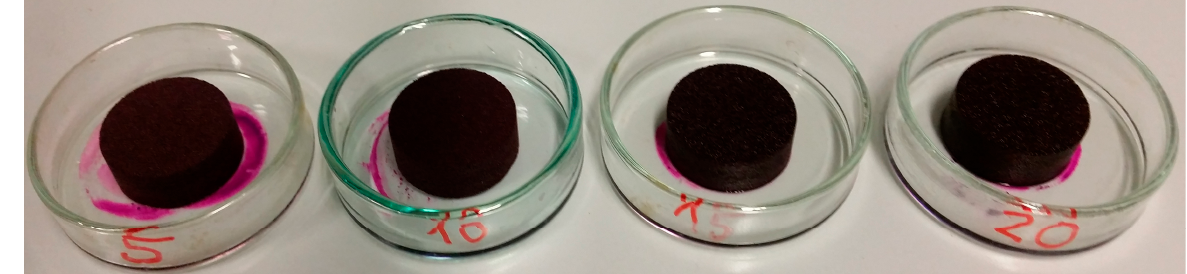
Figure 1. Impregnated catalyst precursors (from left to right: P1S1, P1S2, P1S3, P1S4). The drying process at the normal pressure lasted for 4 h and consisted of 4 different temperature levels set up: 80 ◦ C, 120 ◦ C, 150 ◦ C, 190 ◦ C, 1 h each. Eventually, the dried precursor (see Figure 2) was subjected to the heat treatment.